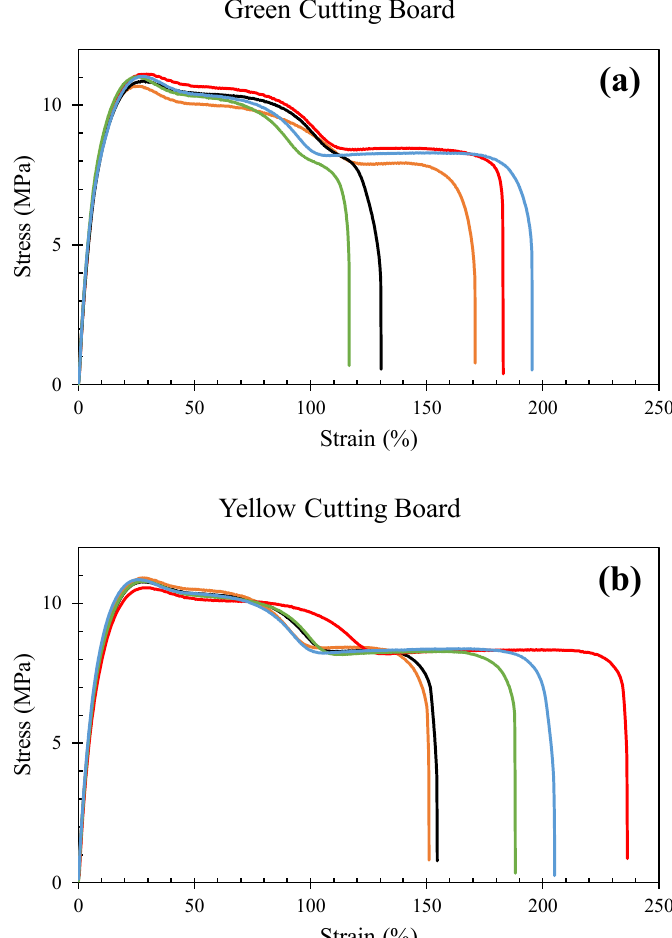
Figure 6. Stress-strain curves of the plastic cutting boards: ( a ) green cutting board (CB-3); and ( b ) yellow cutting board (CB-4). Five tensile specimens were prepared from each cutting board to determine the mean tensile strength of the cutting boards. The different colored lines show the stress-strain curves obtained from tensile tests of the five specimens. It can be observed from the figure that very consistent tensile strength values were obtained for all the five specimens.